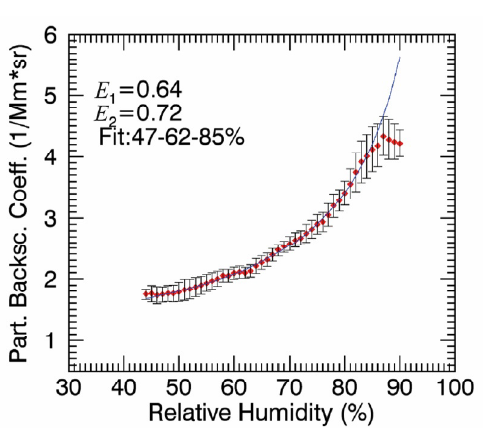
Fig. 1. Particle backscatter coefficient in dependence on relative humidity, 13 August 2015.